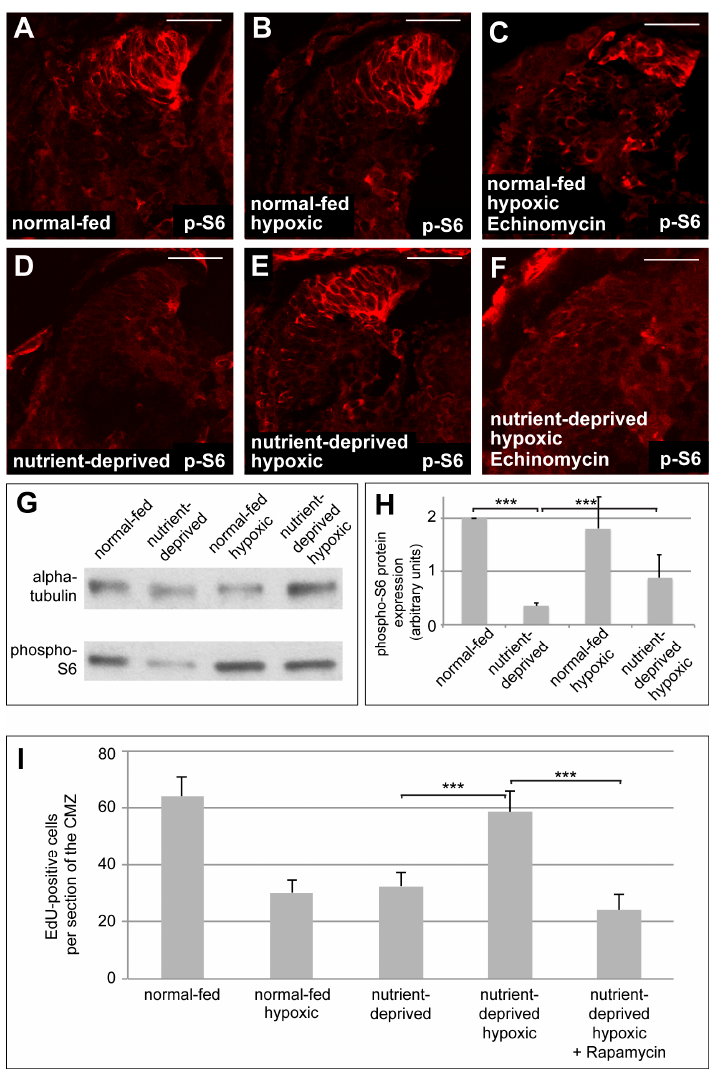
Figure 5. Reactivation of mTOR signalling, mediated by HIF-1 function, is required when nutrient-deprived retinas increase proliferation in hypoxia. ( A – D ) Immunostaining for the mTOR target phospho-S6 (p-S6) in retinas from normal-fed ( A – C ) or nutrient-deprived ( C – E ) animals kept in normal oxygen concentration ( A , D ), under hypoxia ( B , E ) or under hypoxia and treated with Echinomycin ( C , F ). Incubation of nutrient-deprived retinas in hypoxia restores p-S6 staining in the CMZ. Echinomycin treatment interferes with the increase of p-S6 staining in the CMZ of nutrient-deprived hypoxic retinas. Scale bars = 50 µm; n = 3. In each condition, a minimum of 8 retinas was examined. ( G ) Western blot of retinas dissected from normal-fed or nutrient-deprived normoxic or hypoxic animals, probed for phospho-S6 and α -tubulin. At least 22 retinas were taken for each condition, and all conditions in each experiment have the same number of retinas ( n = 10). ( H ) Quantification of the Western blot shown in ( G ). Phospho-S6 levels, normalized to tubulin, are significantly reduced upon nutrient deprivation, unaffected by hypoxia alone, and increase to 40% of control levels upon nutrient deprivation in hypoxia. In Western blot quantification, error bars represent standard deviations between 10 independent experiments. Two hooked ends of horizontal lines indicate the two conditions compared, *** p -values < 0.001; n = 10. ( I ) Quantification of EdU incorporation in retinas from normal-fed or nutrient-deprived animals kept in normoxia, hypoxia or incubated with Rapamycin under hypoxia. Nutrient-deprived retinas no longer resume their proliferation in hypoxia when mTOR signalling is blocked by Rapamycin. Error bars represent standard deviations between two independent experiments. Two hooked ends of horizontal lines indicate the two conditions compared, *** p -values < 0.001; n = 2. For each condition, between 7 and 15 retinas were quantified.